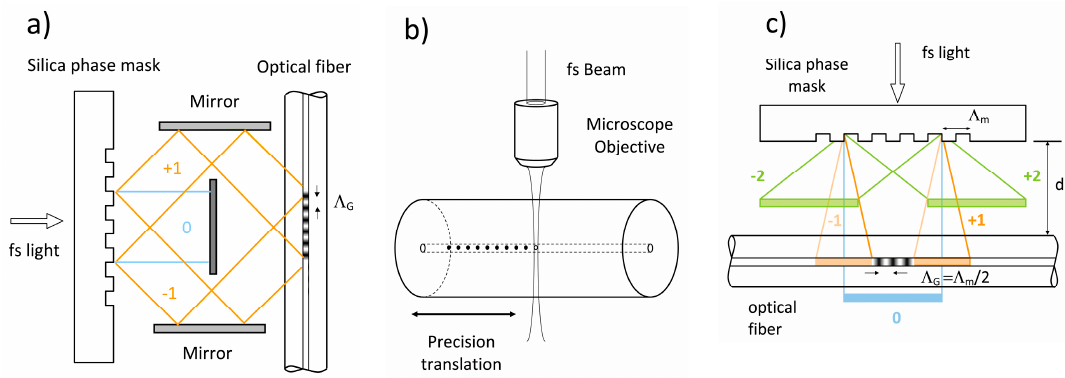
Figure 3. Schematics of principle techniques used for fs-laser inscription of FBGs: ( a ) Talbot interferometer, ( b ) point by point and ( c ) phase mask. Arrows denote period Λ G of the resultant grating. Amber in the figures denotes propagation of the ± 1 orders, green ± 2 order and blue the zero order.